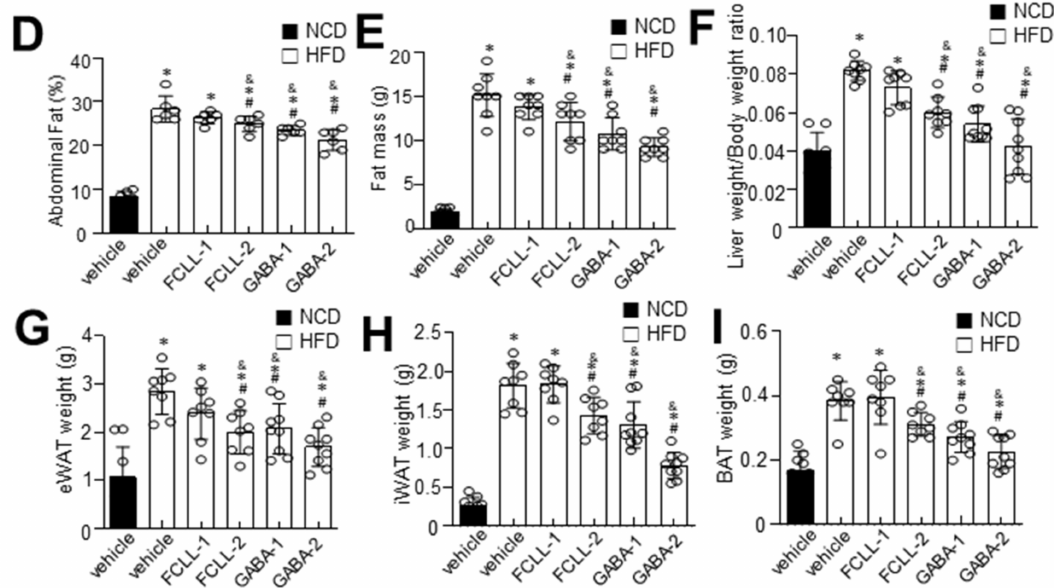
Figure 2. Influence of GABA and fermented Curcuma longa L. extract enriched with GABA on body weight and fat mass. Mice were fed with NCD or HFD with vehicle or GABA and fermented Curcuma longa L. extract enriched with GABA (1 or 2 g/kg) once daily for 14 weeks by oral gavage. ( A ) Changes in body weight were recorded at the indicated times. ( B ) Representative images of HFD mice supplemented with the experimental diet for 14 weeks. ( C ) Representative InAlyzer dual X-ray absorptiometry images showing fat mass. ( D ) Quantification of fat (%) and ( E ) fat mass using InAlyzer dual X-ray absorptiometry images. ( F – I ) Measurement of weights of liver, epididymal white adipose tissue (eWAT), inguinal white adipose tissue (iWAT), and brown adipose tissue (BAT). Data are presented as mean ± SEM ( n = 8, * p < 0.05 vs. NCD + vehicle, & p < 0.05 vs. HFD + FCCL-1, # p < 0.05 vs. HFD + vehicle, ## p < 0.05 vs. HFD + GABA-1). NCD, normal chow diet; HFD, high-fat diet; FCLL, fermented Curcuma longa L. extract enriched with GABA). NCD, normal chow diet;